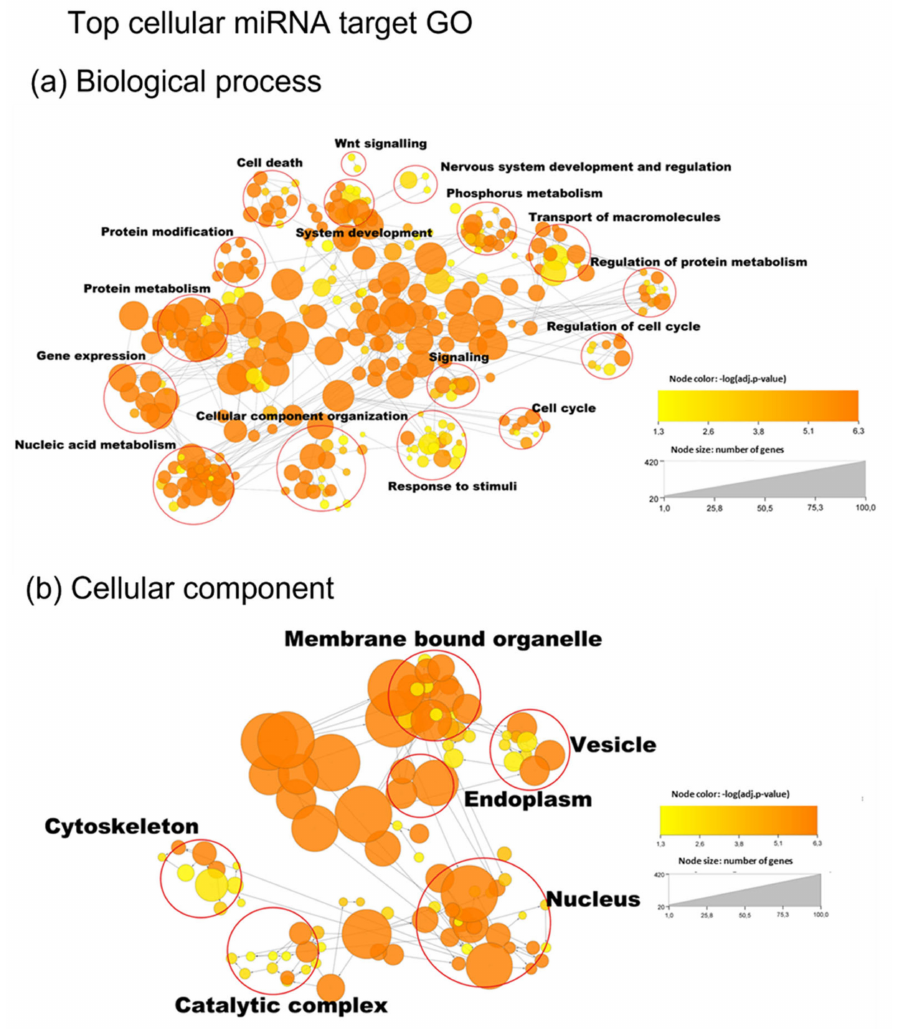
Figure 10. ( a ) GO annotation for biological processes of the cellular miRNA targets (from Figure 8). ( b ) GO annotation for cellular component of the cellular miRNA targets (from Figure 8). Analysis performed using the BINGO app in Cytoscape_v3.9.1, with the adjusted p -value < 0.03 and the number of genes above